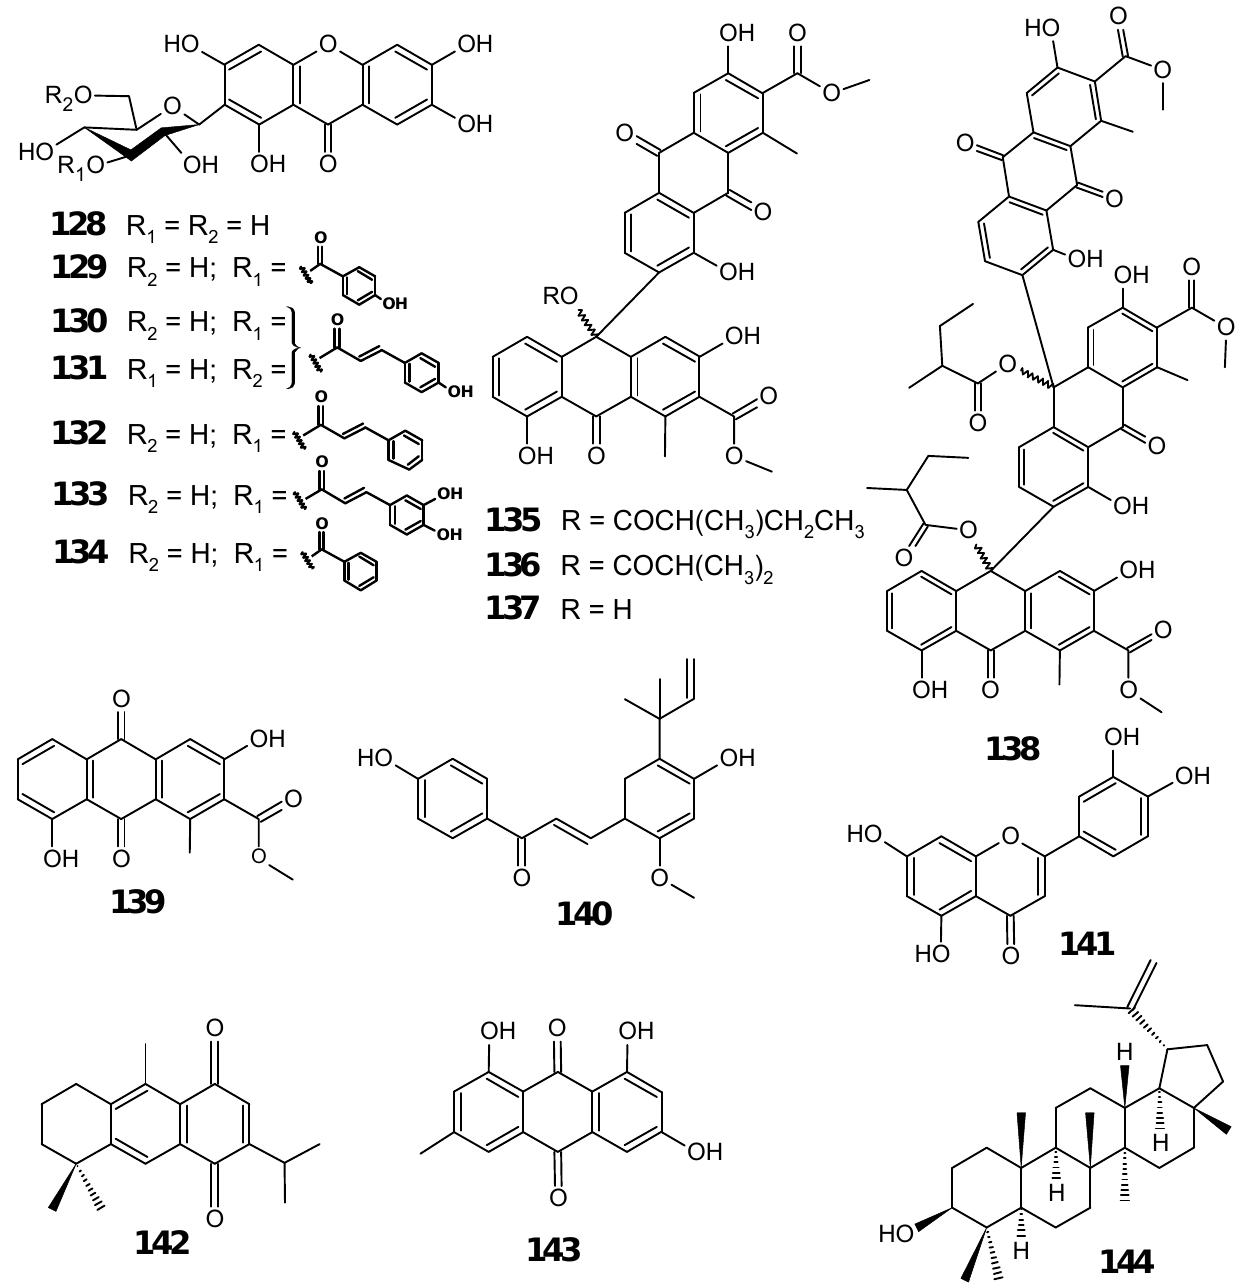
Figure 14. Antiplasmodial flavonoids and related compounds 128-144